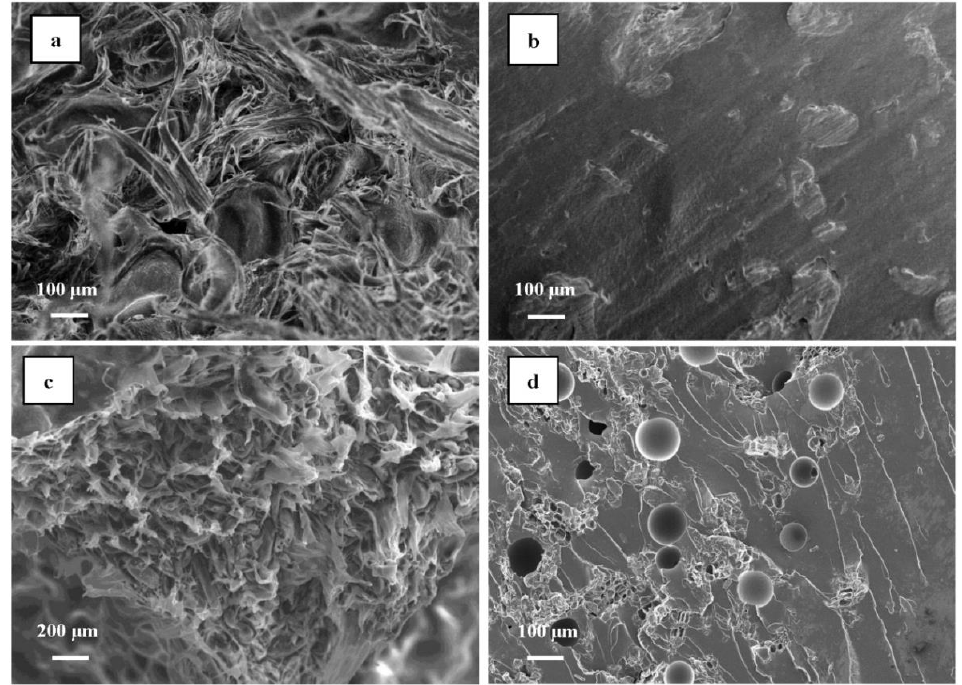
Figure 7. FE-SEM images of fracture surfaces for the nanocellulose/cork/epoxy resin composites: ( a ) CNF/epoxy, ( b ) NCC/epoxy, ( c ) CNF/cork/epoxy, ( d ) NCC/cork/epoxy.